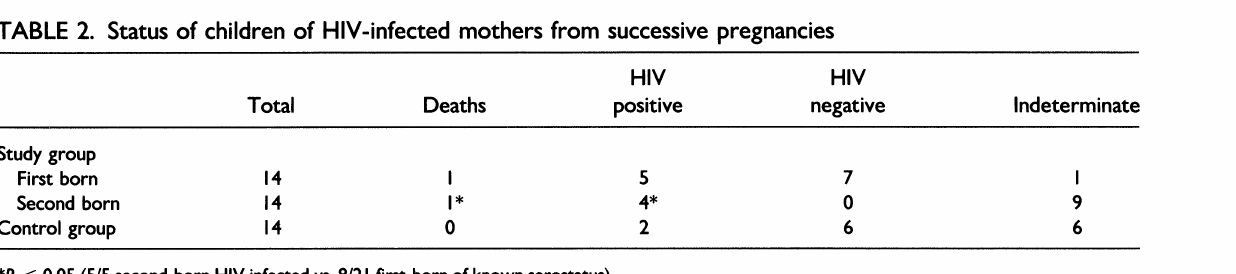
TABLE 2. Status of children of HIV-infected mothers from successive